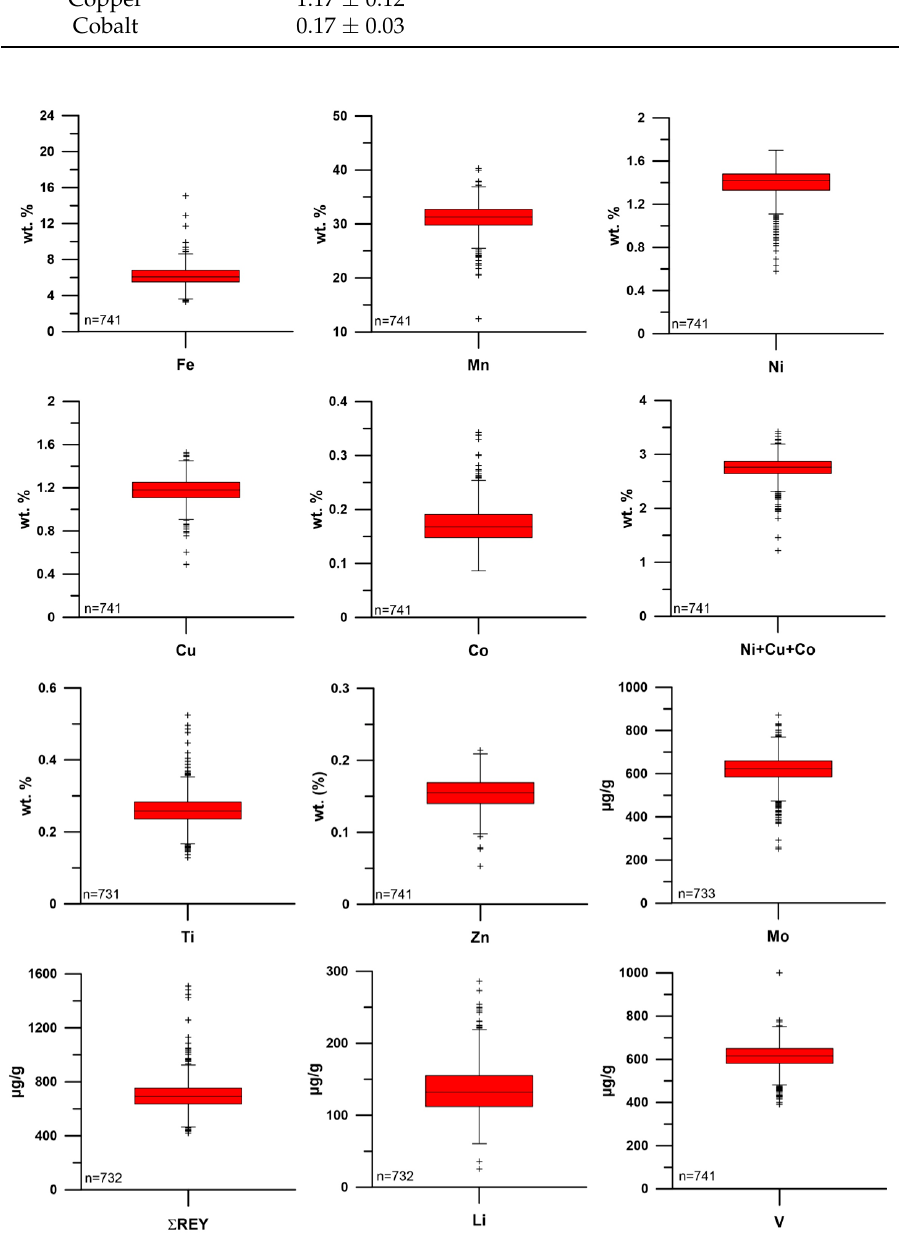
Figure 9. Box-and-whisker plots of some major, minor and trace elements in nodules from Area E1. The red boxes mark 50% of all data bordered by the quartiles (25% and 75%). The central line indicates the median, and the whiskers are minimum and maximum values. Crosses mark outliers defined as being larger than ± 1.5 times the interquartile range. The average water content (salt-corrected) is 32 ± 2.2% (mean ± 1 σ ), with values rang- ing between 21% and 40% (Figure 10). Two values of 9% and 46% were considered as outliers and were not included in the calculation of the mean, and three other values only slightly deviate from the majority of the measurements. The CoV is 7%, similar to the value of 8% for the sum of the main metals.